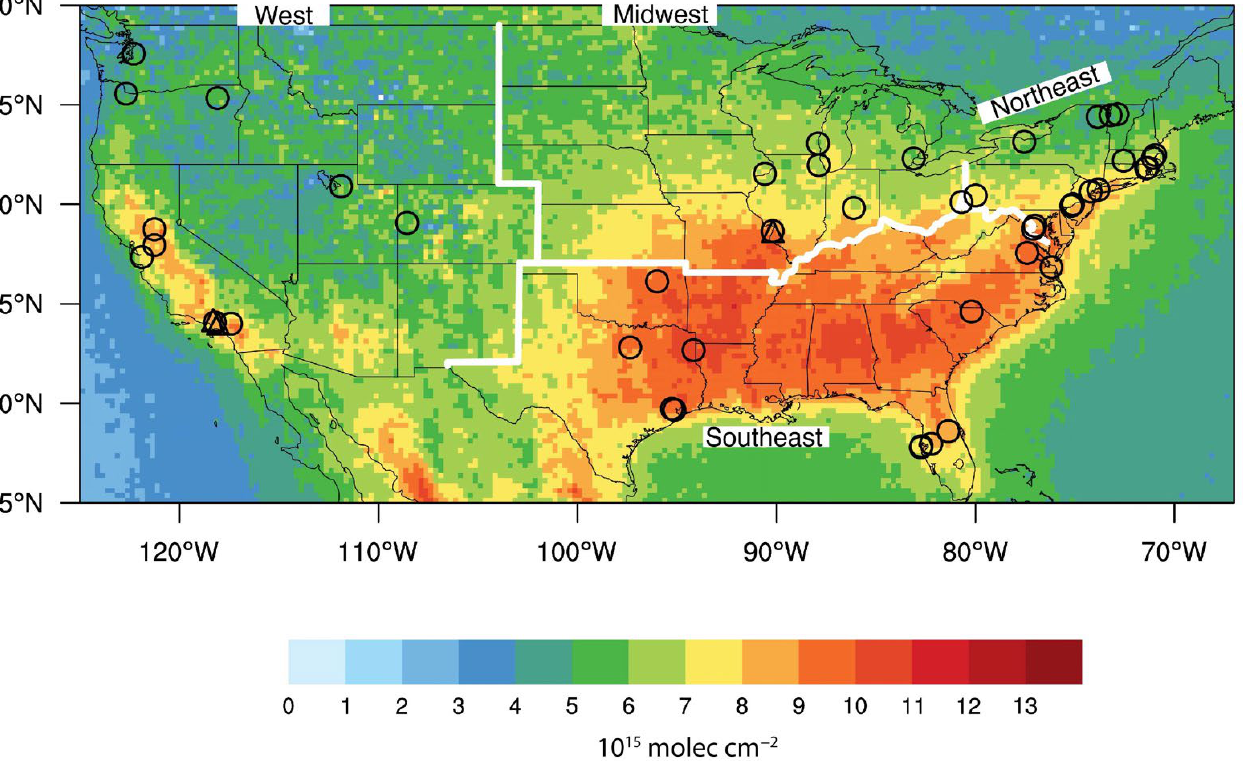
Figure 1. 2006–2015 annual average HCHO vertical column density from OMI. Four U.S. regions are designated for analysis, with region name aside the map. Overall, for studying diurnal patterns, there are three sites: two in the Western U.S. and one in the Midwest. These stations are labeled as triangles. For seasonal and interannual studies, there are 45 AQS stations (10 in the west, 6 in the Midwest, 14 in the southeast and 15 in the northeast) that are labeled as circles. For more details on monitoring sites, please see Section 2.1 and Table 1.